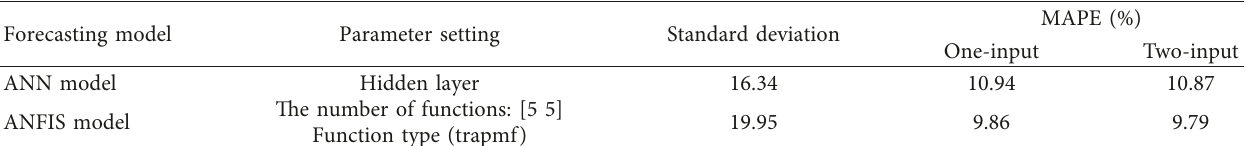
Table 7: ANN and ANFIS model prediction accuracy.